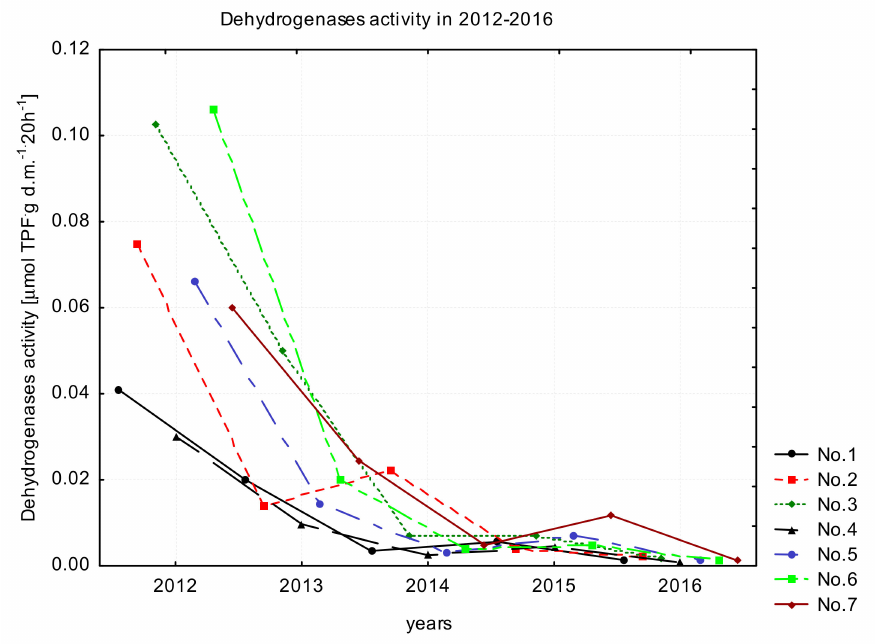
Figure 8. Annual average dehydrogenases activity in A horizons.